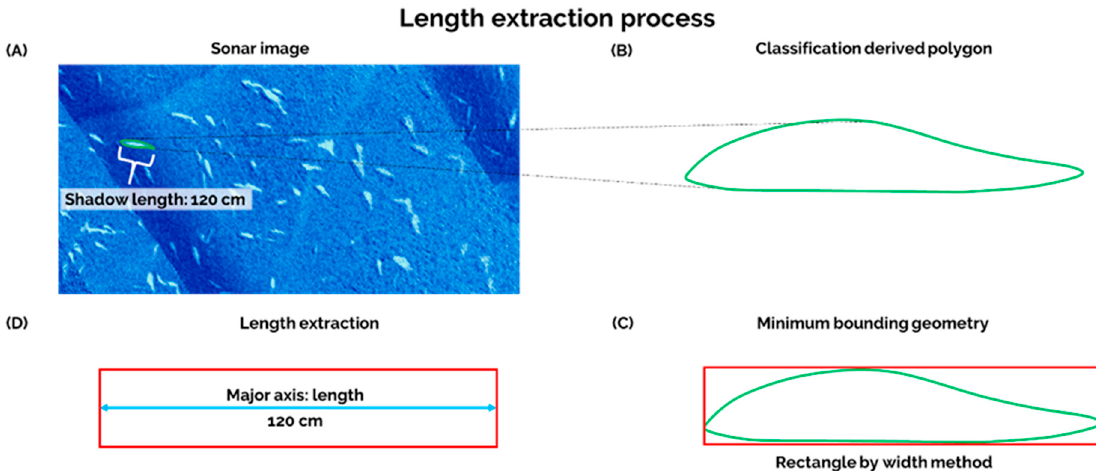
Figure 3. Conceptual overview of the length extraction process. ( A ) An example image from the December 2018 sonar survey where the white objects are potential Shortnose Sturgeon. ( B ) An example of a polygon classified by supervised Maximum Likelihood Classification (sMLC). ( C ) The minimum bounding geometry output, a rectangle, is superimposed on the classified polygon (see text). ( D ) The final extracted length obtained from the minimum bounding geometry output in ( C ).